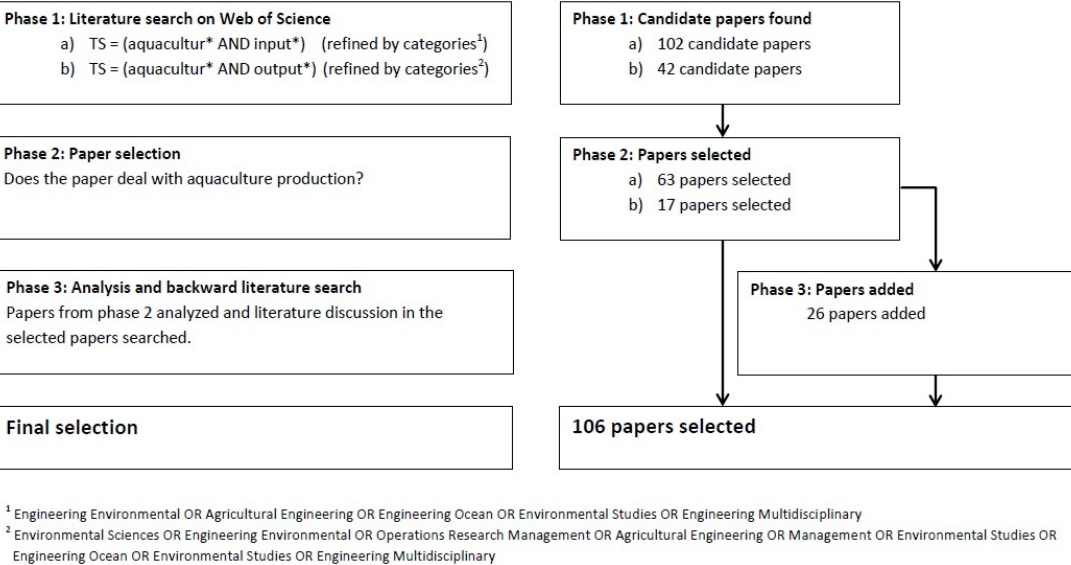
Figure 1. The searching, selecting, and processing steps used to determine the final set of papers used for the observation. for the